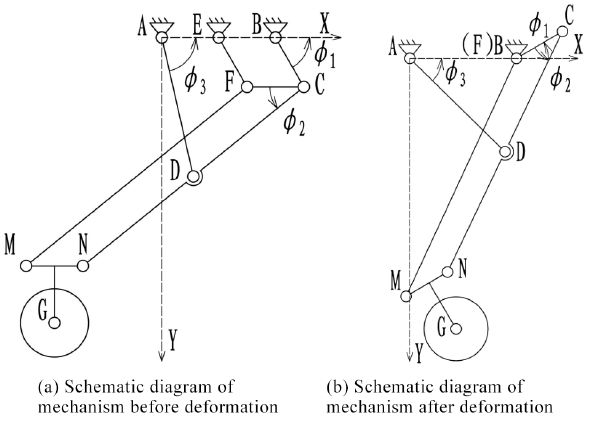
Figure 5. The structure diagram of the end effector (a) . The 3D model diagram of the end effector (b) .